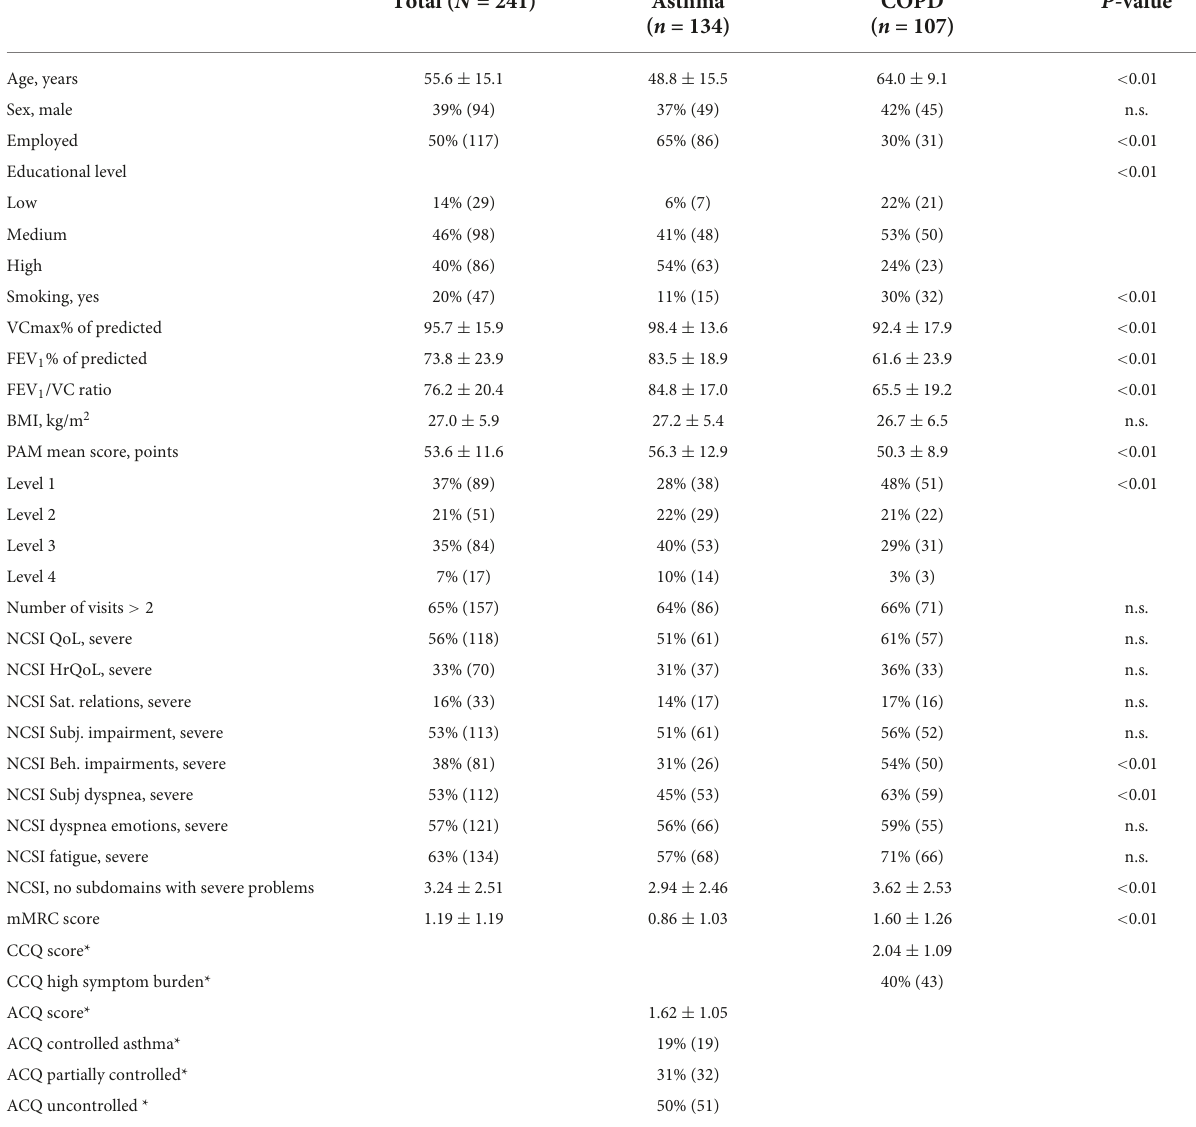
TABLE 1 Patient characteristics and percentages of severe problems on NCSI, CCQ and ACQ at baseline for whole study group and for confirmed diagnosis of asthma and